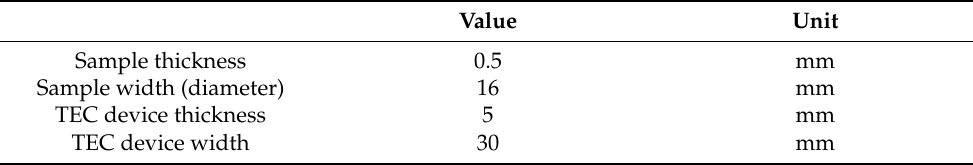
Table 1. Geometry parameters in the simulation.